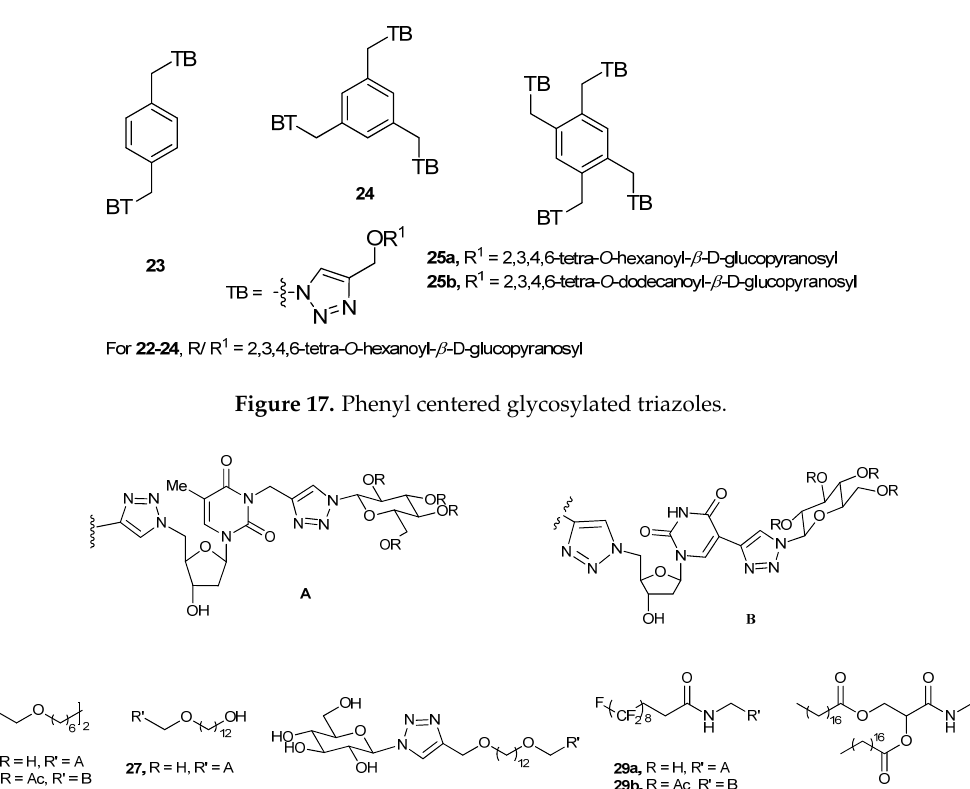
Figure 18. Glycosyl triazole anchored thymidine and uridine based glycolipids.